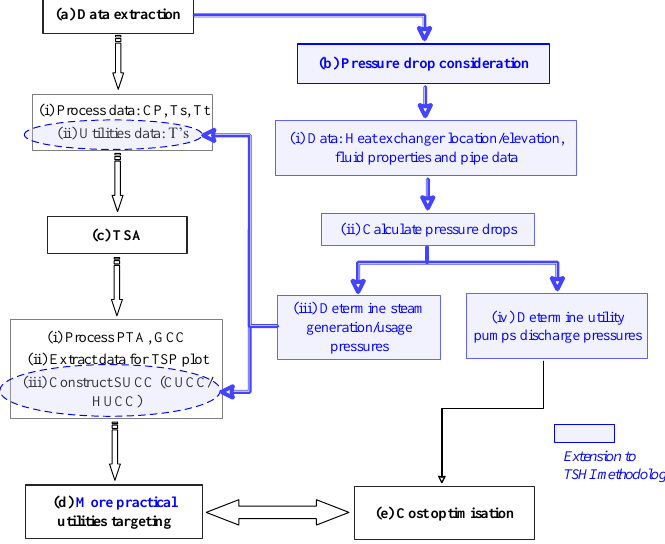
Figure 6. Algorithm to consider pressure drops in